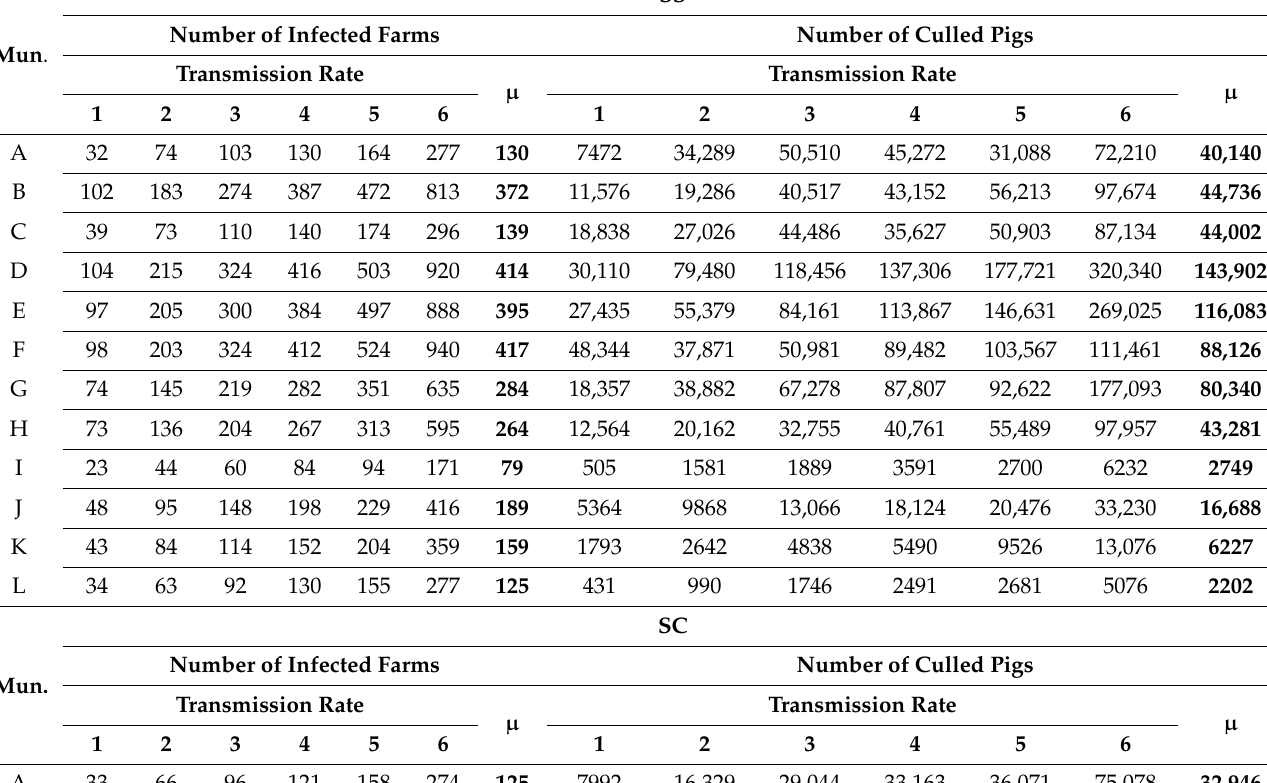
Table 4. Overview of the numerical output per